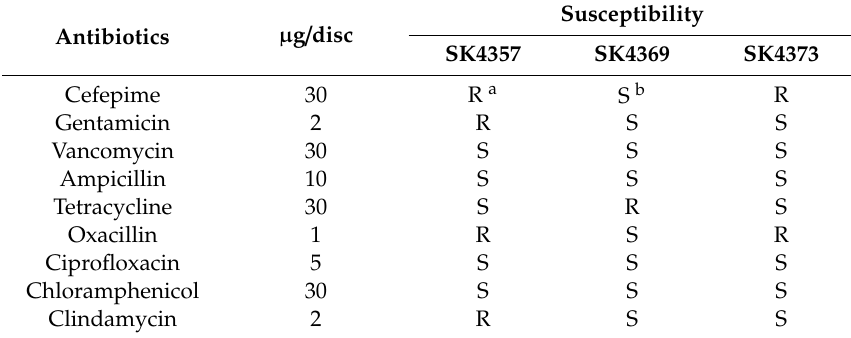
Table 3. Antibiotic resistance of E.